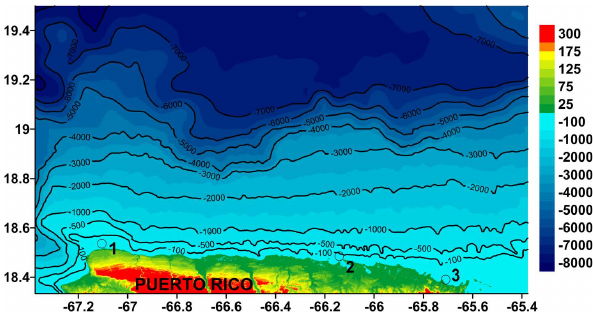
Fig. 5. Topographic (positive) and bathymetric (negative) data in meters, used in PRNS model simulations (axes are in degrees of W Long. and N Lat.). Composite of ETOPO-2 data (above 19 ◦ N Lat.; Fig. 1) and NGDC 3 00 Coastal Relief Model (Divins and Metzger, 2008), interpolated by krigging on a 3 00 by 3 00 grid. Symbols ( ◦ ) marked 1–3 are locations of time series shown in Fig.